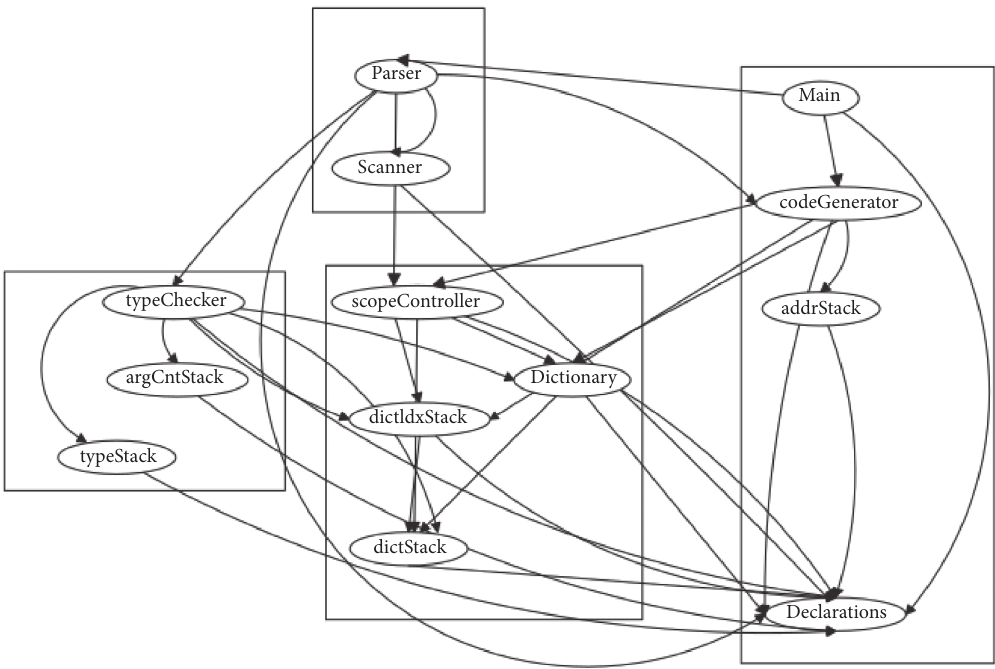
Figure 4: An example of clustering